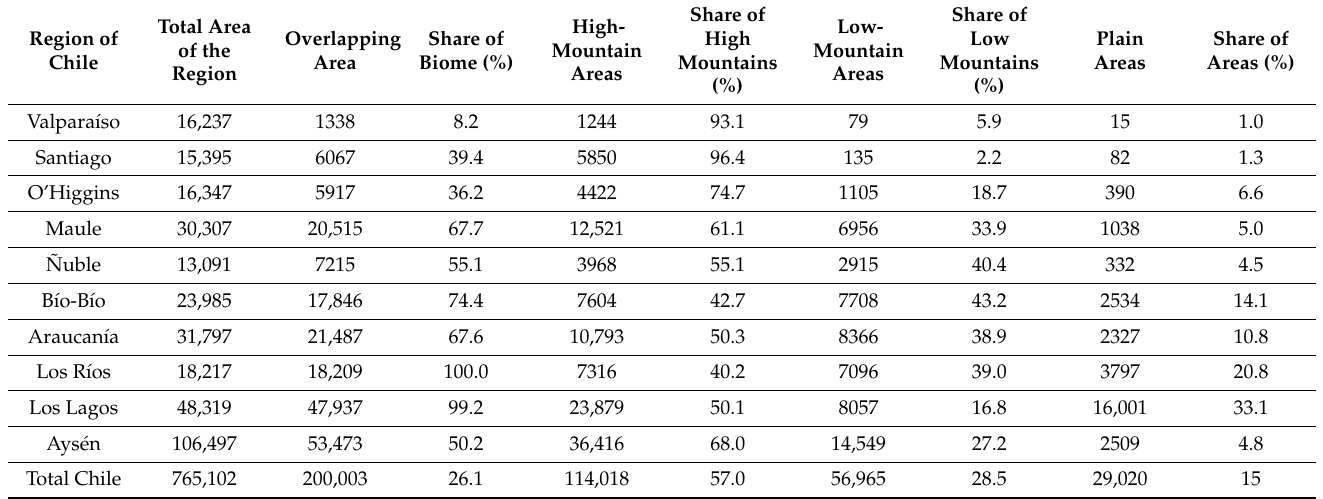
Table 1. Size and share of Valdivian temperate rainforest biome and mountain and areas in over- lapping zones in Chilean regions in km 2 Source: Own calculations out of databases mentioned in methodology